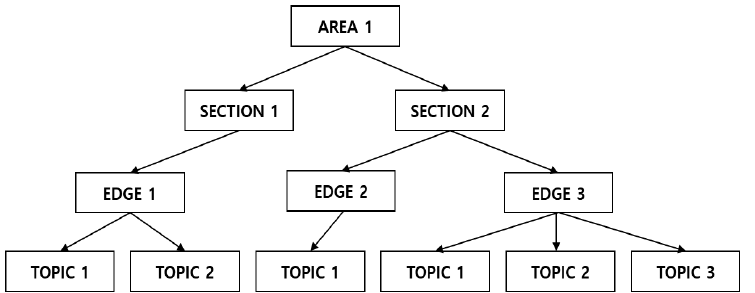
Figure 4. Data publication